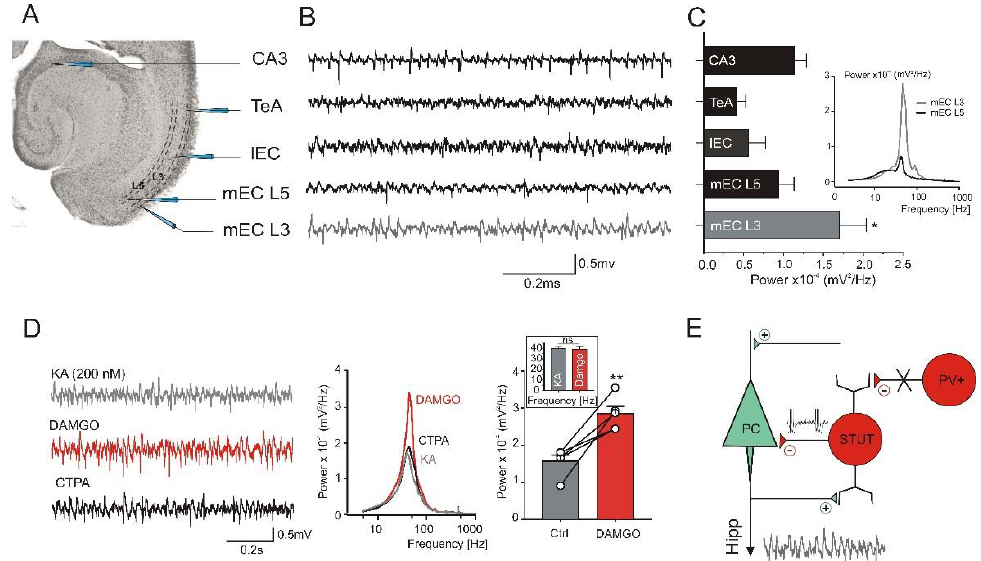
Figure 6. Opioid receptor agonist promotes gamma frequency oscillations in superficial mEC. ( A , B ) Gamma frequency oscillations in EC – hippocampal combined slices induced by low molarity of kainate. ( C ) The oscillatory activity was observed in all recorded areas but with different power. Peak power of gamma frequency oscillations within the mEC was significantly stronger in superficial layers (L3) compared to deep layer (L5). p value is given as * ( p ≤ 0.05) . ( D ) Effect of opioid receptor agonist damgo on network oscillations in mEC L3 ( left ). The power of gamma frequency oscillations was significantly increased in the presence of damgo, whereas the corresponding frequency remained unchanged ( right ). p values are given as ns ( p > 0.05) and ** ( p ≤ 0.01) . The effect of damgo was reversed by the μ -opioid receptor antagonist, CTPA ( middle ). ( E ) Scheme with a possible explanation of μ -opioid receptor activation on the properties of STUT and network oscillations. During field oscillation the active PCs of L3 provide excitatory tonic input to STUT which cause the feedback inhibition. μ -opioid receptor activation at PV-positive IN-STUT (in red) synapses causes disinhibition of STUT, which increases their gamma frequency-patterned output to the PCs, leading to increases in the field gamma frequency oscillations.